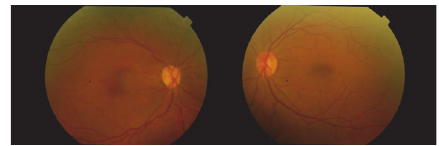
Figure 1: Initial photographs of the patient; central retinal artery occlusion in the right eye. Left eye is normal.